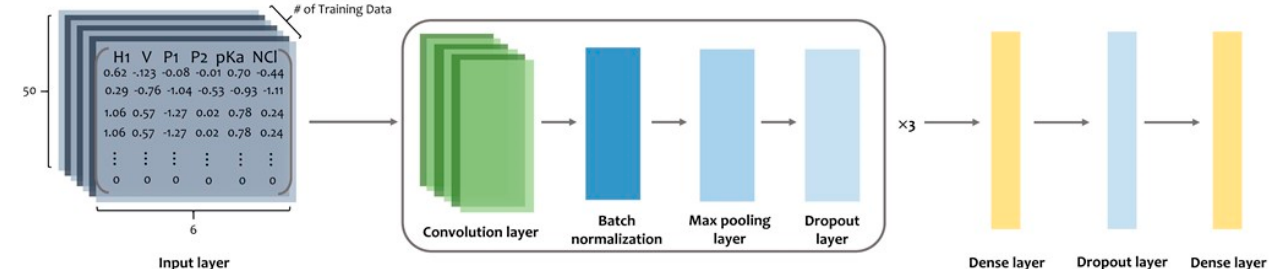
Figure 5. PC6 protein − encoding method. A padded ACP will be transformed into a 50 × 6 matrix. Subsequently, we implemented the neural network using Keras